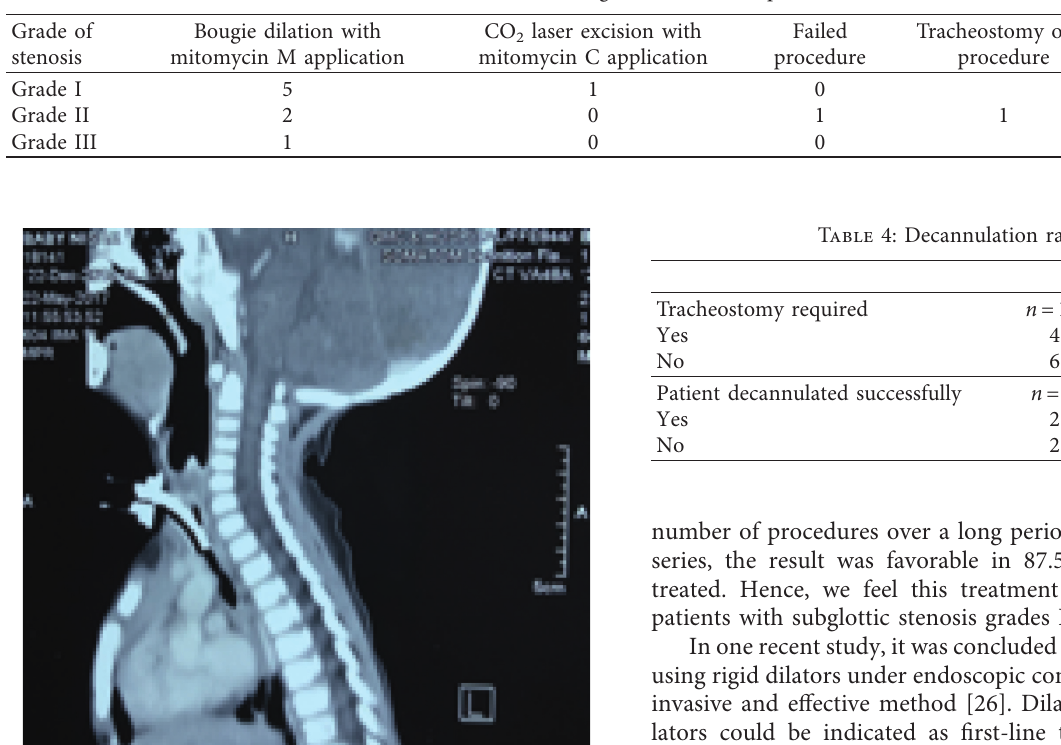
Table 3: Modes of surgical intervention performed.